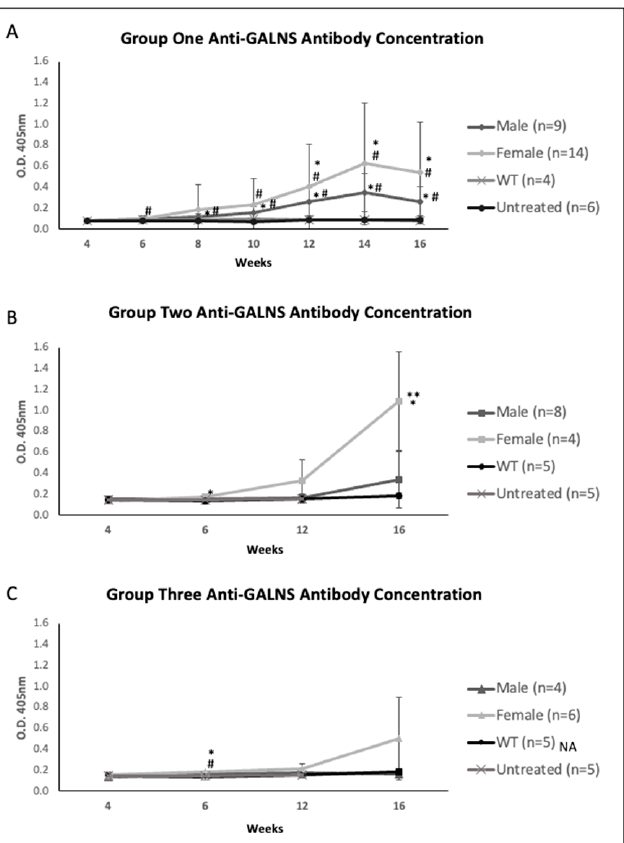
Figure 4. Plasma anti-GALNS antibody concentration of ( A ) Group One (mice treated with the TBG promoter; 5 × 10 13 GC/kg body weight), ( B ) Group Two (mice treated with the CAG promoter; 5 × 10 13 GC/kg body weight), and ( C ) Group Three (mice treated with the TBG promoter; 2 × 10 14 GC/kg body weight). Concentrations are displayed as optical density absorption rates at the 405 nm wavelength. Error bars display standard deviation. * indicates a two-tailed t -test p -value of <0.05 compared to the WT cohort. ** indicates a two-tailed t -test p -value of <0.05 compared to the opposite sex. # indicates a two-tailed t -test p -value of <0.05 compared to the untreated cohort. GALNS: N-acetylgalactosamine-6-sulfate sulfatase, TBG: thyroxine-binding globulin, CAG: a ubiquitous pro- moter including a cytomegalovirus enhancer element, a chicken β -actin promoter, and an intron, WT: wild-type.